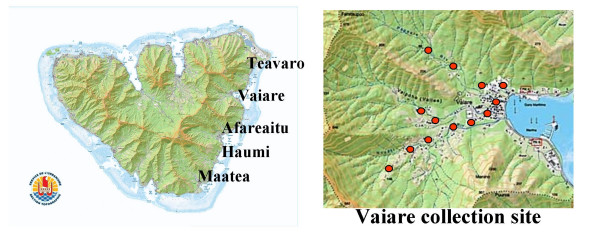
Situation map of Moorea island (scale : 1 cm = 4 km). Left panel : Localization of the study area and the 5 collection sites Right panel : repartition of the collection "stations" in the collection site of Vaiare